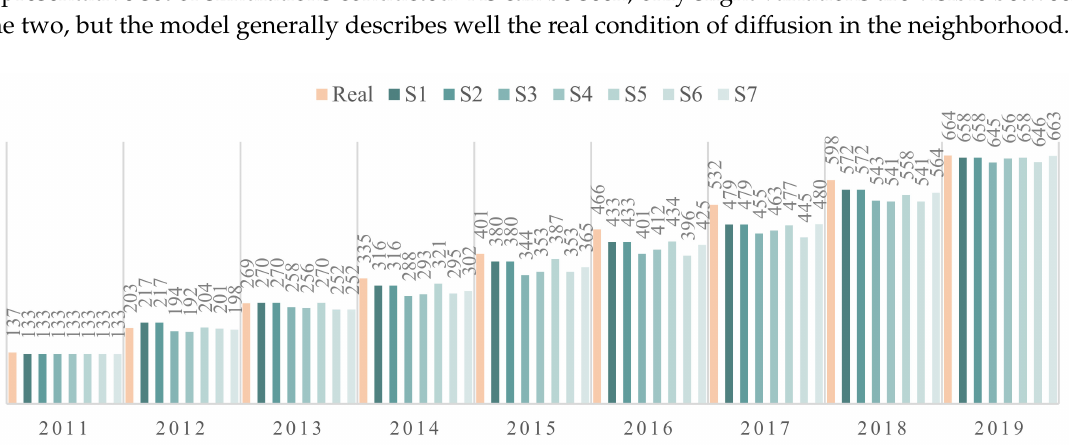
Figure 5. Comparison between real-world data of PV adoptions (pink) and seven exemplary simulation results